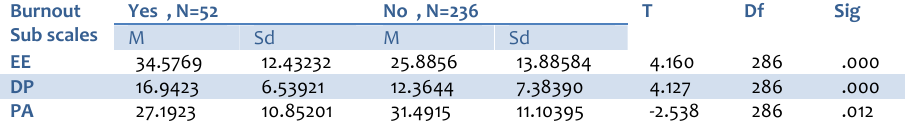
Table 9: T-test on mean difference of burnout based on conflict with students Yes , N=52 No , N=236 Burnout Sub